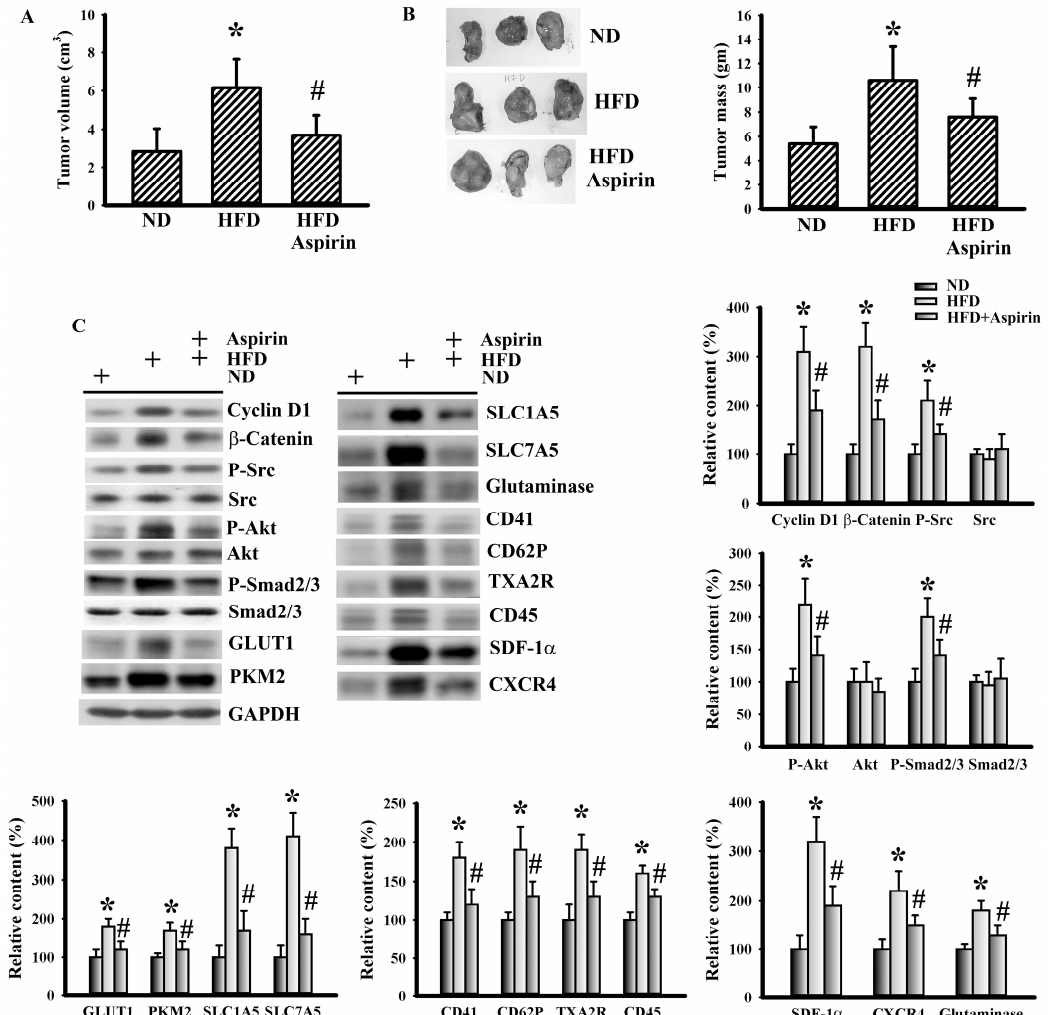
Figure 5. Aspirin mitigated tumor growth in obese mice. LLC cells (LLC) were implanted into the lean (ND) and obese (HFD) mice and grew for 3 weeks. Three days after implantation, aspirin (20 mg / kg) was administrated daily up until the end of the experiment. The tumor volume ( A ) and tumor mass ( B ) were weighed and analyzed. The representative resected tumors are shown ( B ). Proteins were extracted from the resected tumor tissues and subjected to Western blot with indicated antibodies. Representative blot is shown ( C ). Quantitative data are depicted and the content in ND was defined as 100%. * p < 0.05 vs. ND and # p < 0.05 vs. HFD (n = 6 per group).